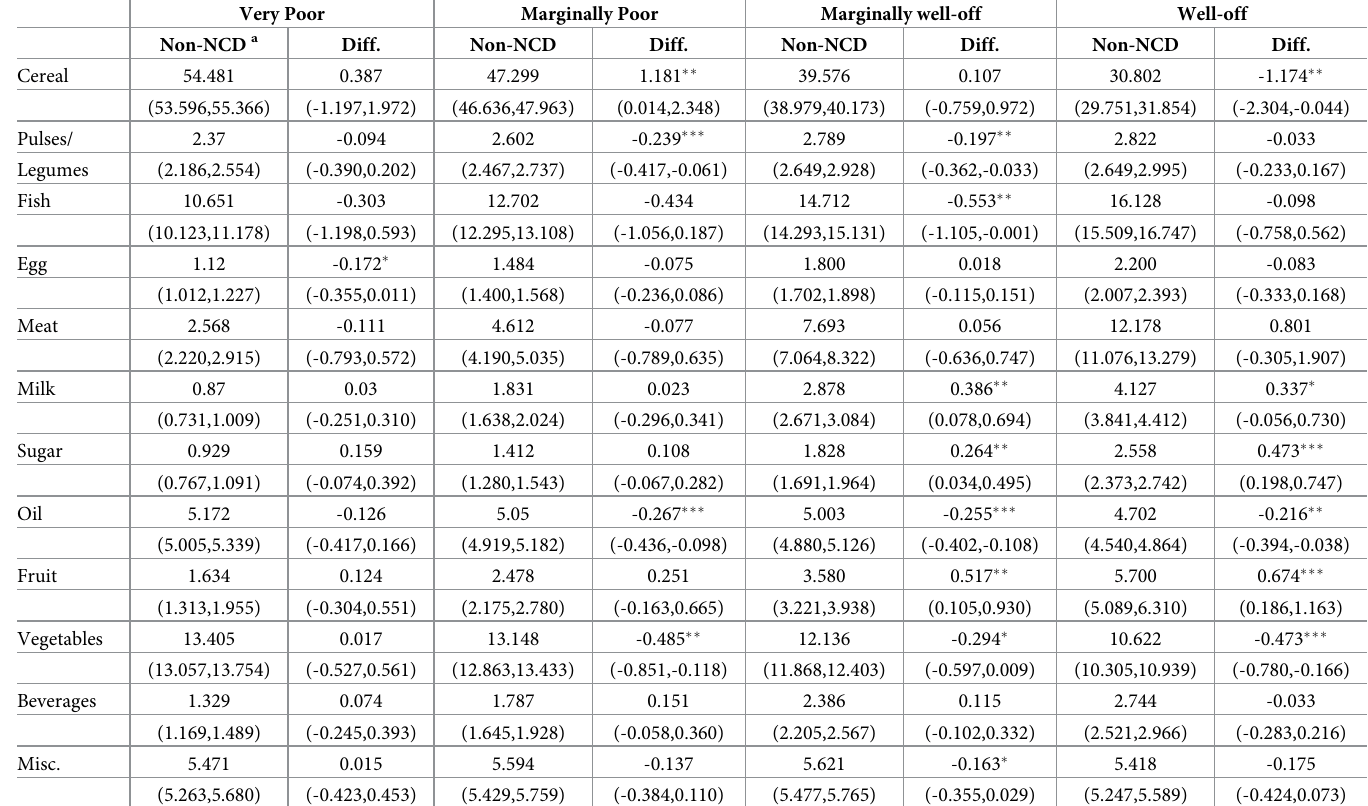
Table 6. Unadjusted differences in food expenditure categories between NCD and non-NCD households, by household